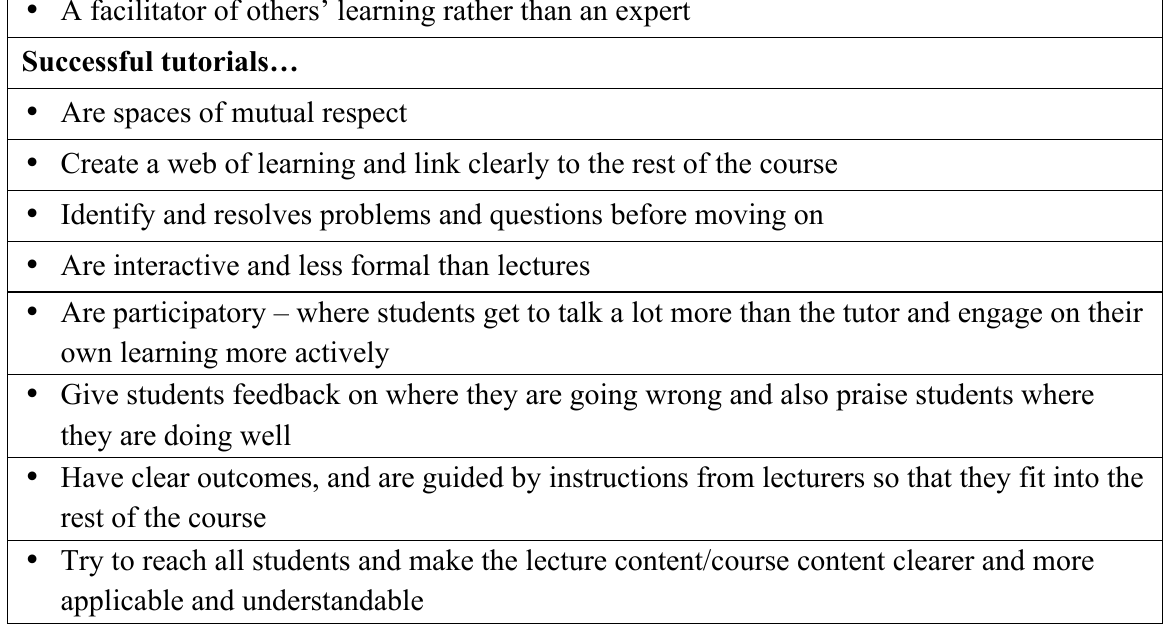
Figure 3: Example of matrix ranking exercise ‘manifesto’,